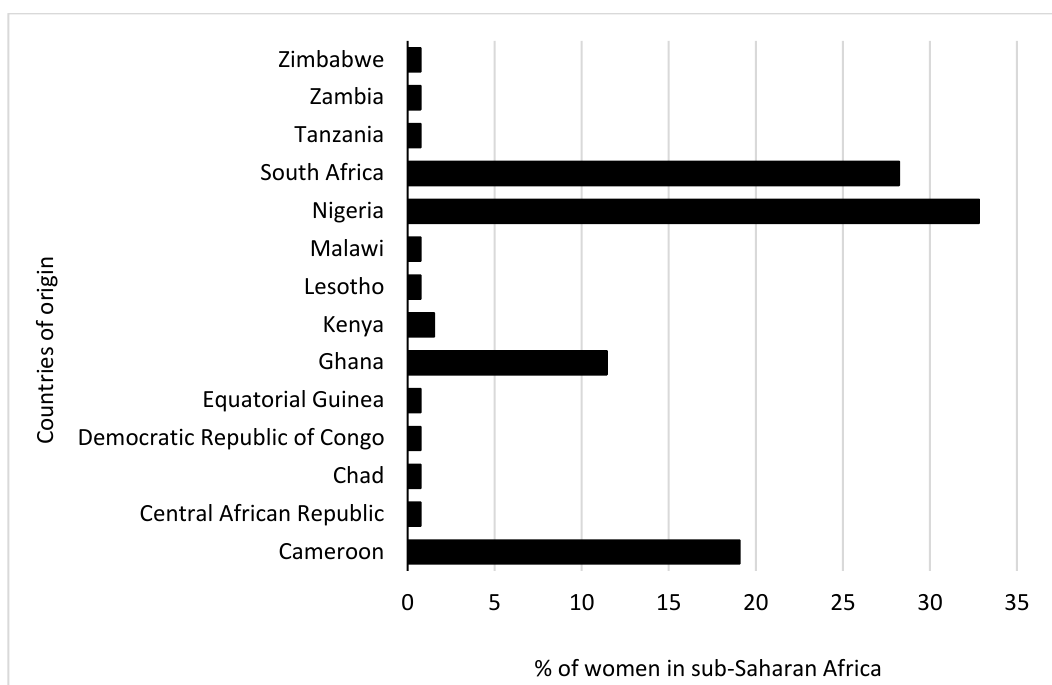
Figure 2. The proportion of women in sub-Saharan Africa by country of origin.